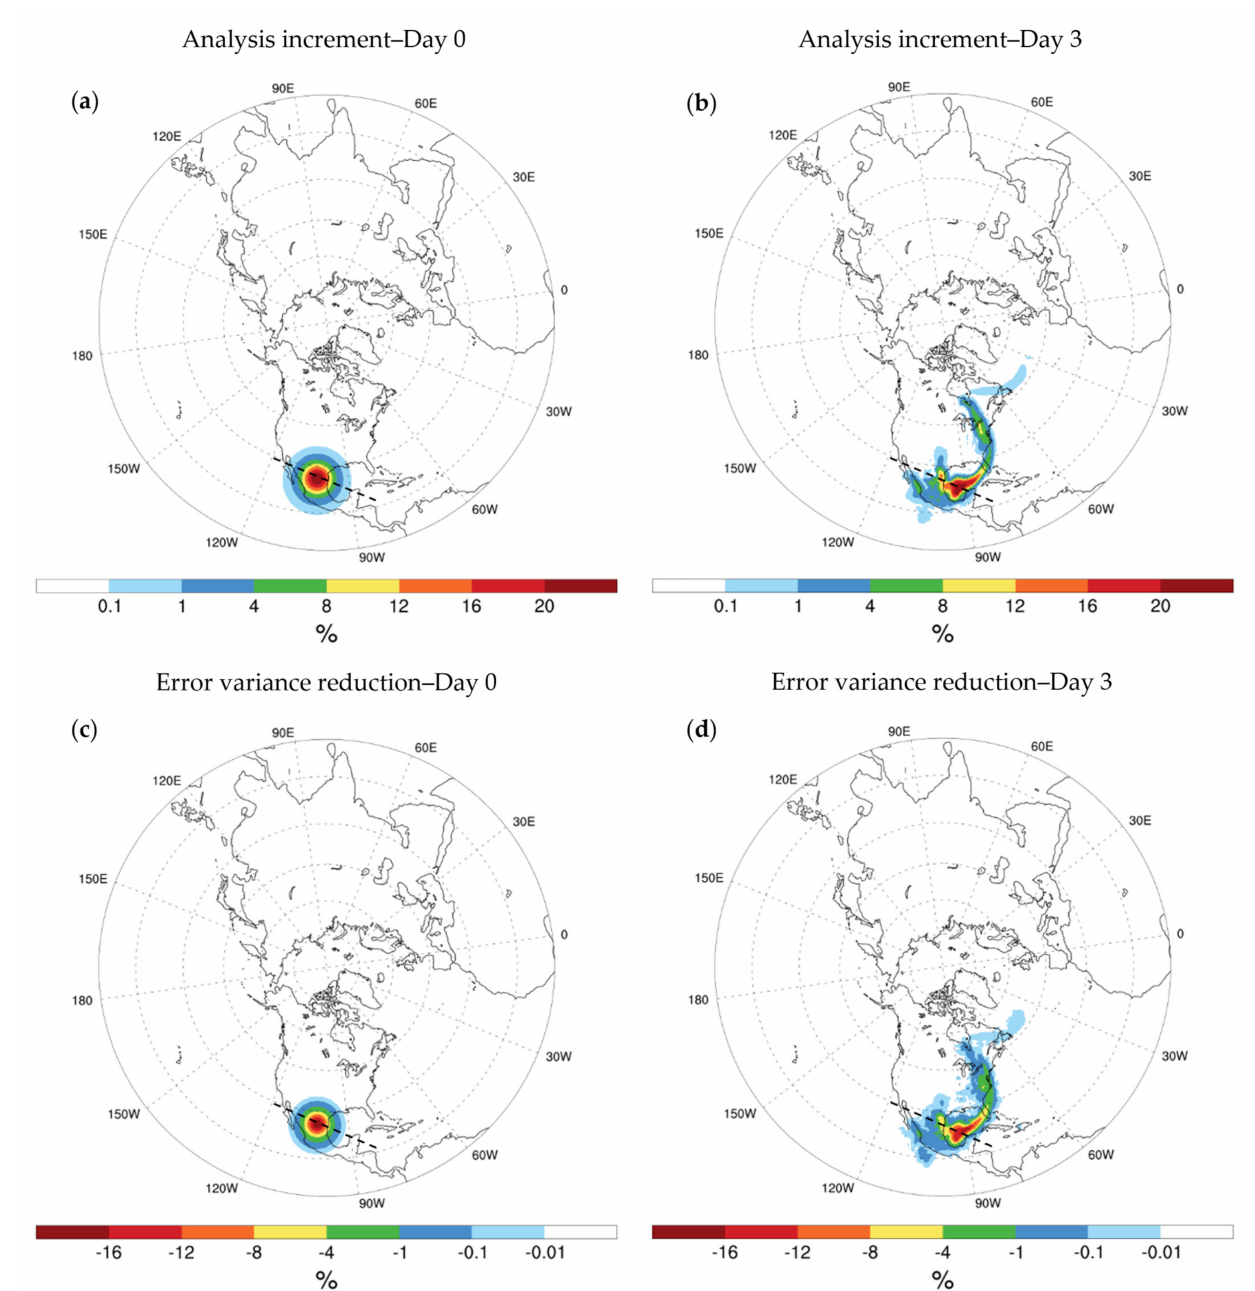
Figure 7. The second one-observation experiment at about 600 hPa and lower latitude (27 ◦ N,105 ◦ W) to show ( a ) the analysis increment at Day 0 and ( b ) Day 3; and ( c ) the error variance reduction at Day 0, and ( d ) Day 3. The dashed (black) line represents a cross-section along the vertical direction, where the vertical distribution of the analysis and its error variance are demonstrated in Figure